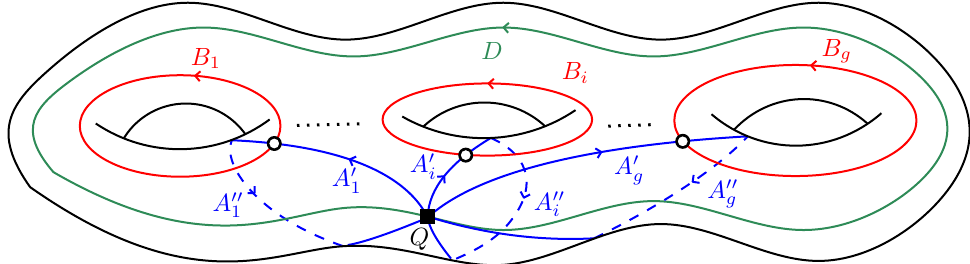
Figure 6. Genus- g surface cut along red and blue cycles.